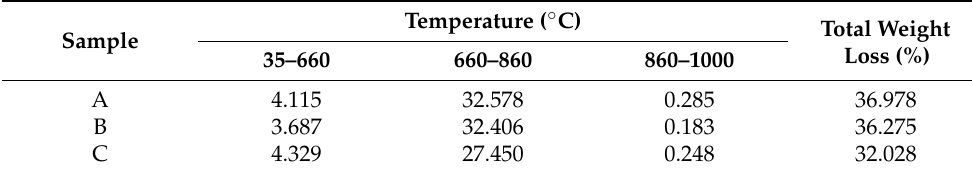
Table 4. Weight losses (%) of the A, B, and C mortar samples.